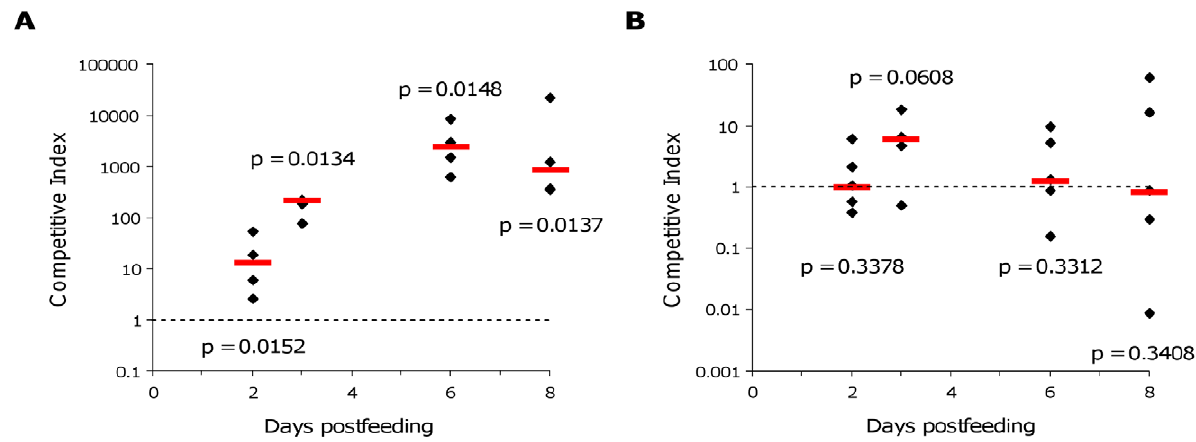
Figure 9. Chicken cecal colonization by E.coli strains BEN2908 and BEN2908 D fosT . Eleven-day-old axenic (A) and SPF (B) White Leghorn chickens were fed with strains BEN2908 and BEN2908 D fosT together (each at 5 6 10 7 CFU/chicken). Animals were euthanized on days 2, 3, 6 and 8 post-inoculation by injection of Nesdonal and then necropsied. The proportion of each strain in animal cecal content was monitored over time and CI were calculated. Horizontal red bars indicate the median of CI and diamonds indicate individual CI. Statistical analyses were conducted using the Mann-Whitney U-test, measuring the difference between CI in cecal content and in the inoculum. The calculated P values are presented, with values below 0.05 considered significant.